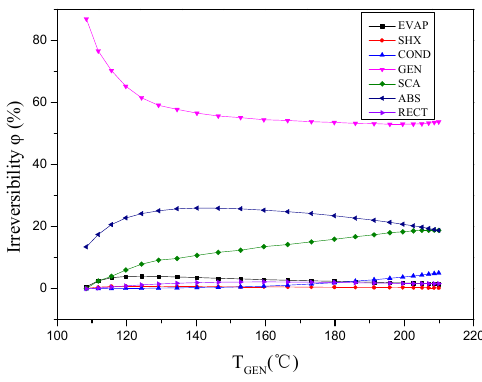
Figure 9. Irreversibility φ of main components versus T GEN at T COND = 54 °C .